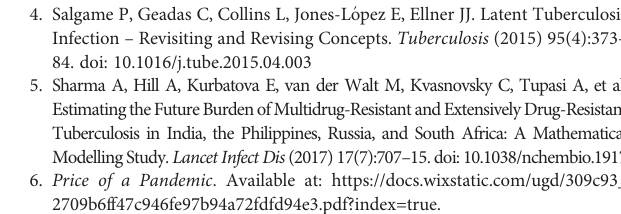
signi fi cant *P ≤ 0.05; **P ≤ 0.01. Asterisks without the line below show the signi fi cance compared to the untreated group. Supplementary Figure 3 | Effectoflate-onsetberberineadjunctivetherapyonlung and spleen immunecells populationsduring Mtb infection inC57BL/6 mice. (A) Lung CXCR3 + CD4andCD8 T cellfrequencies, (B) lungalveolar macrophage (SiglecF + CD11c + CD64 + ), (C) lunginterstitial macrophages (CD64 + CD11b + CD11c - SiglecF - ), (D) lungmonocyte-derived DCcounts (CD64 + CD11b + CD11c + ), (E) spleen CXCR3 + CD4andCD8 T cellfrequencies, (F) spleen CD169 + macrophage (CD11b + CD169 + CD11c - ) (G) spleen red pulp macrophage (F4/80 + CD11b low CD169 - CD11c - ), (H) spleen CD8 DCcounts (CD11c + MHCII + CD8 + CD11b - ).Data isshown representative of two experiments (n= 5 per group)and the line denotes mean value, analysedbyone-wayANOVAwithTukey post-hoc test (A – C,E – F) andKruskal-Wallis testwithDunn ’ smultiplecomparisonscorrection(D,G)de fi ningdifferencesinallgroups assigni fi cant*P ≤ 0.05;**P ≤ 0.01;***P ≤ 0.001.Asteriskswithoutthelinebelowshow the signi fi cance compared to the untreated group. Supplementary Figure 4 | Effect of late-onset of berberine adjunctive therapy on lung and spleen cytokines/chemokines and receptor gene expression during Mtb infection in C57BL/6 mice. Lung and spleen homogenates were analyzed for the cytokines and chemokines by ELISA at 4 weeks post-treatment; (A) IFN g , (B) IL-1 b , (C) IL-12p40, (D) CXCL10, (E) GM-CSF, and (F) IFN- b . (G) Total RNA was extracted from lung tissue and qPCR was performed to measure Ifngr1 and Csf2ra levels. Hprt housekeeping gene was used for normalization and fold change differences were calculated by using untreated as the reference sample. Data is shown representative of two experiments (n = 5 per group) and the line denotes mean value, analysed by one-way ANOVA with Tukey post-hoc test (A – F) and Kruskal-Wallis test with Dunn ’ s multiple comparisons correction (G) de fi ning differences in all groups as signi fi cant *P ≤ 0.05; **P ≤ 0.01; ***P ≤ 0.001. Asterisks without the line below show the signi fi cance compared to the untreated group. Supplementary Figure 5 | Berberine as an adjunctive therapy against Mtb infection in C3HeB/FeJ (Kramnik) mice. (A) Mice were infected with Mtb Erdman (100 CFU) via aerosol inhalation. After 3 weeks of infection, mice were either left untreated or treated with berberine (1 mg/ml) or rifampin/isoniazid (0.1 mg/ml) and rifampin/isoniazid with berberine in drinking water for 4 weeks as shown in the layout. (B) Mycobacterial burdens in the lungs. (C) Representative lung section for pathology evaluated by H&E staining. (D) Quanti fi cation of free alveolar air spaces. Single-cell suspension of the lung was analyzed for immune cell populations by fl ow cytometry. (E) Total lung cells, (F) T cells (CD3 + CD11b - Ly6G - Ly6C - ), (G) polymorphonuclear cells (CD11b + Ly6G + Ly6C + ) and (H) in fl ammatory monocytes (CD11b + Ly6G - Ly6C + ) in the lungs at 4 weeks post-treatment. Data represented as mean ± SEM of n = 3-4 mice per group from one experiment, analysed by